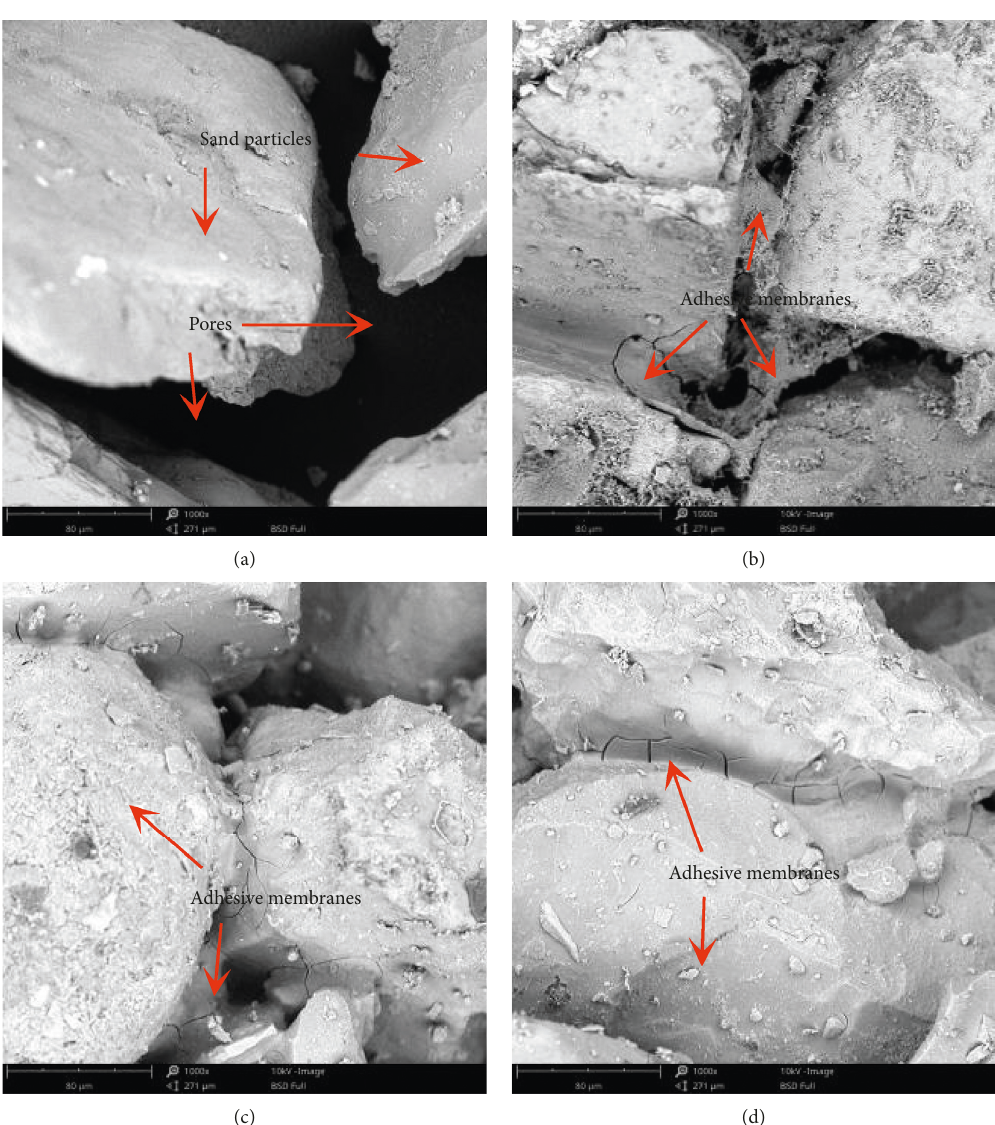
Figure 1: SEM images of sand particles and samples. (a) Sand particles. (b) Modulus 3.2. (c) Modulus 3.3. (d) Modulus